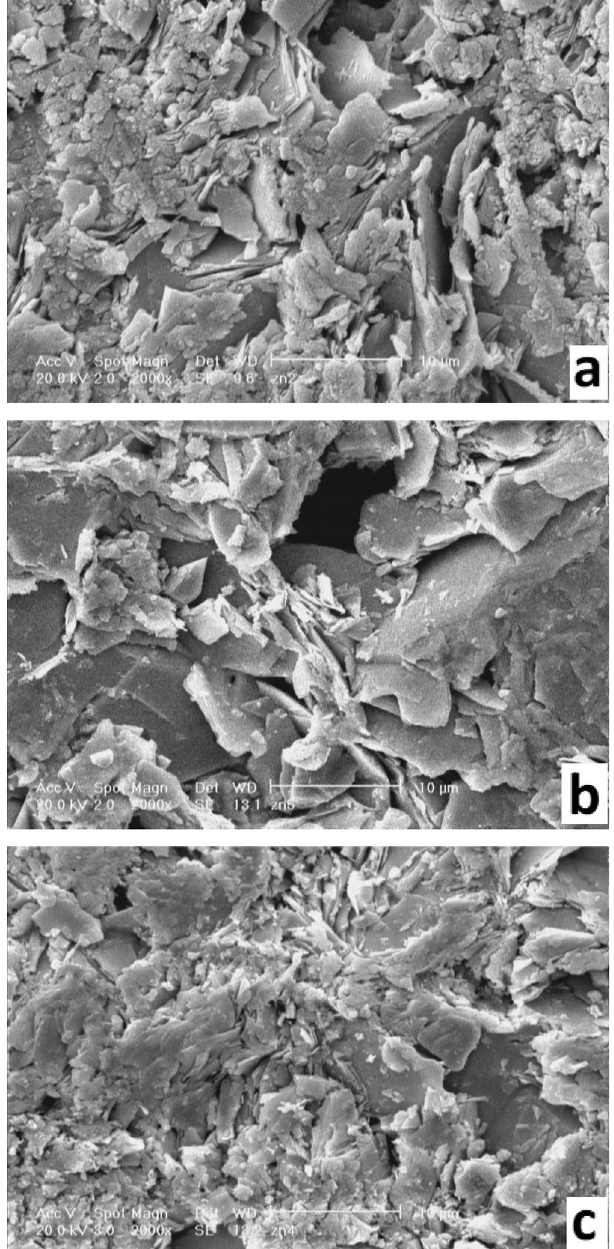
Figure 2. SEM micrographs of the (Bi, Pb)-2223/(ZnO NPs)x composite samples with ( a ) x = 0.0, ( b ) x = 0.2 and (c) x = 1.0